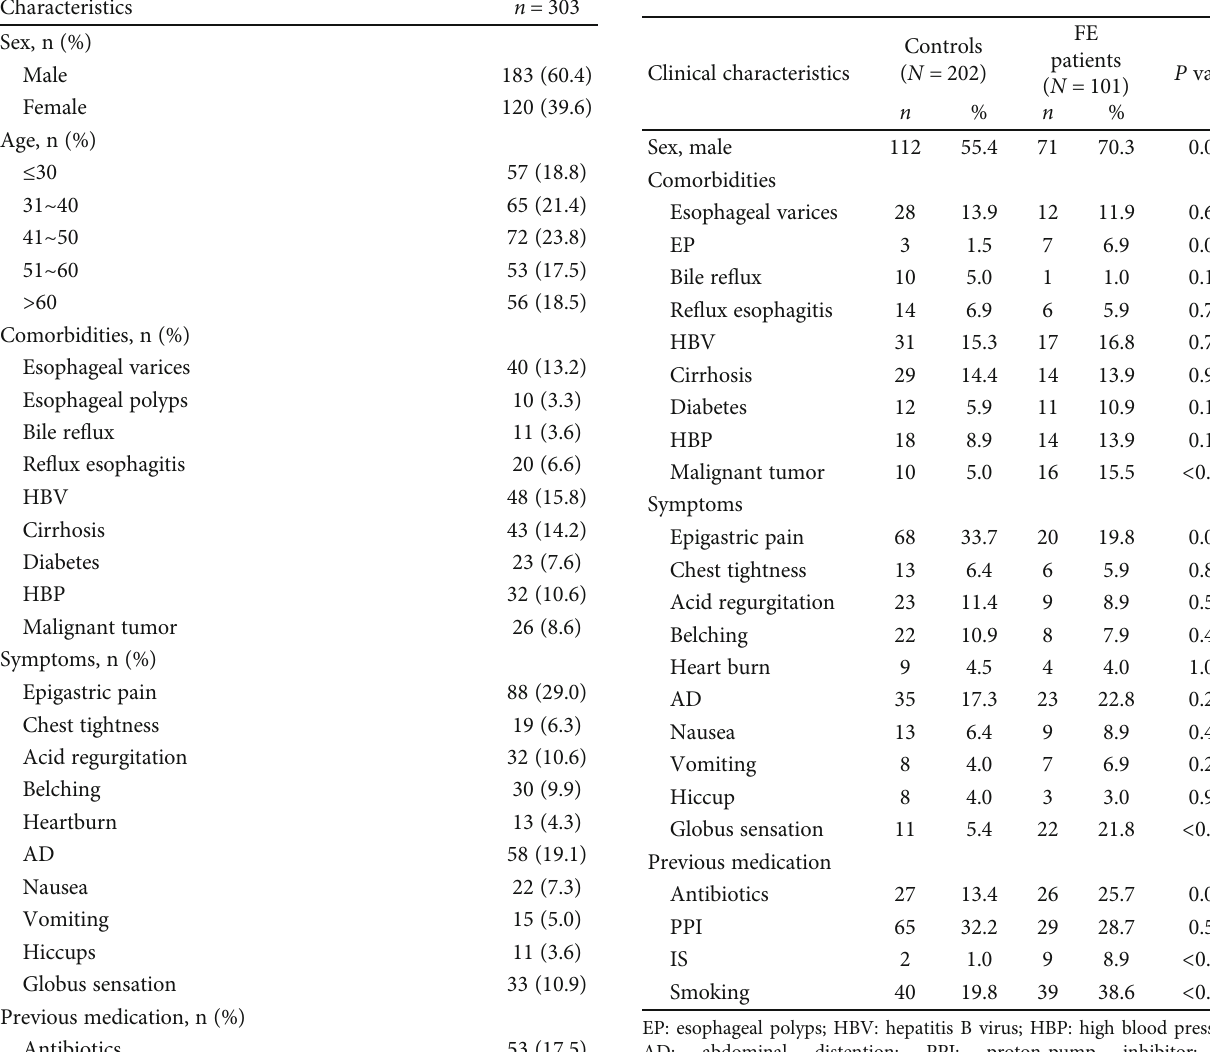
Table 1: Characteristics of FE patients and controls. Table 2: Comparison of the clinical characteristics between FE patients and